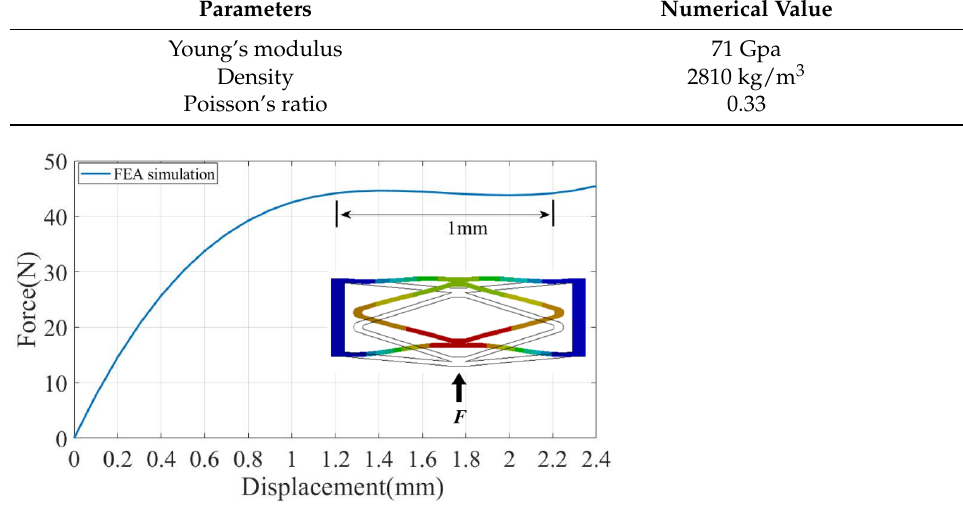
Figure 9. FEA results of the CFM.